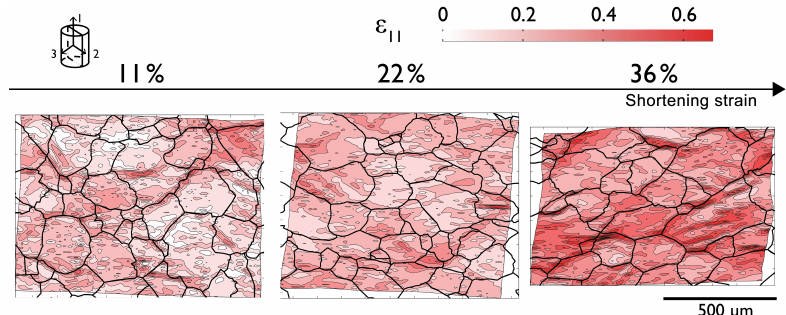
Figure 11. Strain maps for ε 11 computed with an n -point technique (with n = 9) for samples of Carrara marble deformed at T = 600 ◦ C, P c = 300MPa, and 3 × 10 − 5 s − 1 to 11, 22, and 36% shortening strain. The strain component along the shortening direction is mapped with the overlaying grain boundaries. Positive strains correspond to shortening